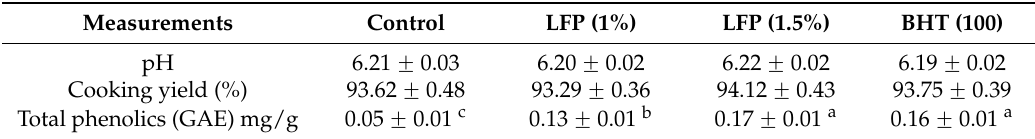
Table 2. Effect of litchi fruit pericarp extracts and BHT on pH, product yield and total phenolics of sheep meat nuggets.